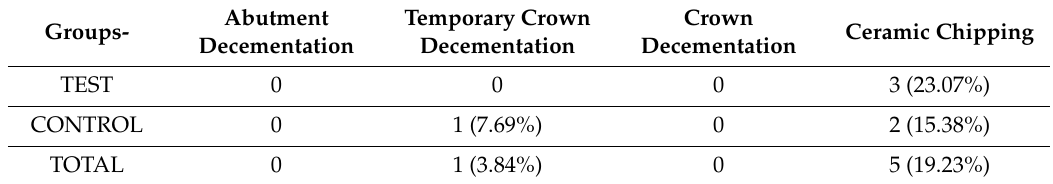
Table 3. The prosthetic complications in both groups.